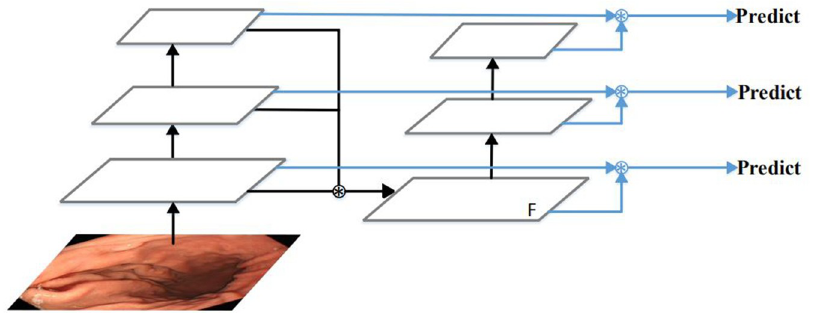
Fig 3. The feature extraction and fusion